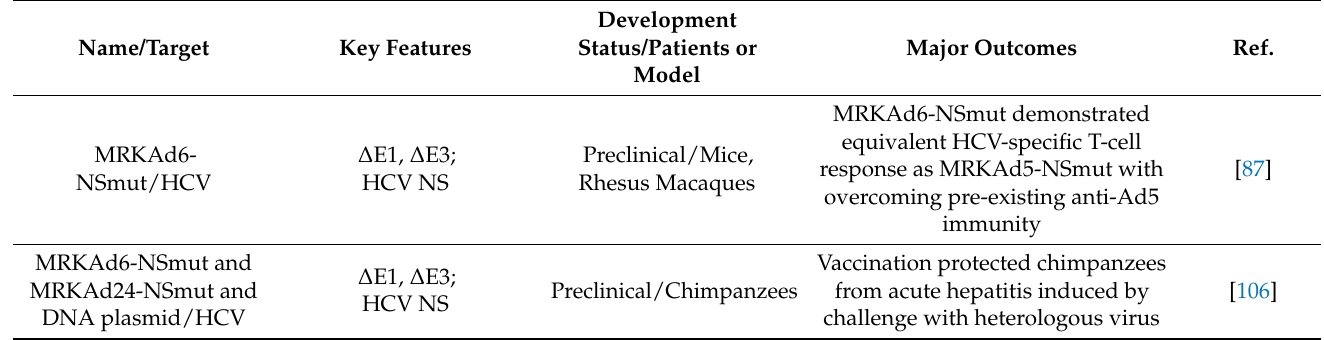
Table 2. Ad6-based vaccines against infectious